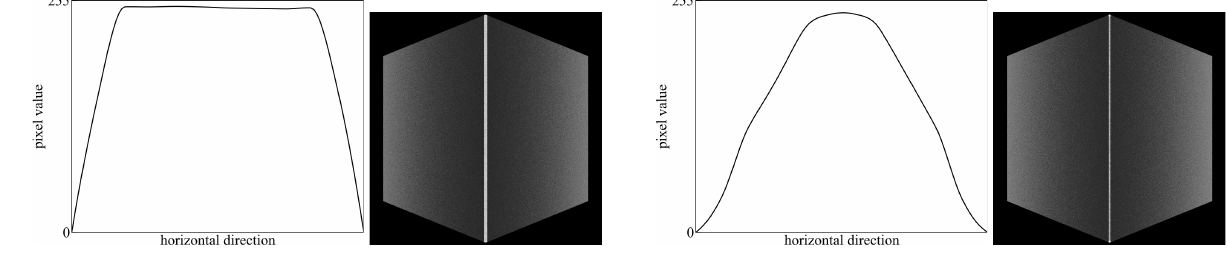
Figure 3. Verification experiment of the function of type (a). The Figure 5. Verification experiment that is similar to Figure 3 for right image shows the edge-highlighting result of a point-based the function of type (b). The parameters are set to L = 100 , f th = 0 . 1 , α min = 0 . 2 , α max = 1 . 0 , d = 3 . 0 . The opacity of 3D model consisting of two joined squares. The graph on the left shows the change in pixel intensity around the 3D edge in nonedge regions is set to 0 . 2 . the horizontal direction in the right image. The parameters are set to L = 100 , f th = 0 . 1 , α max = 0 . 9 . The opacity of non-edge regions is set to 0 . 2 .